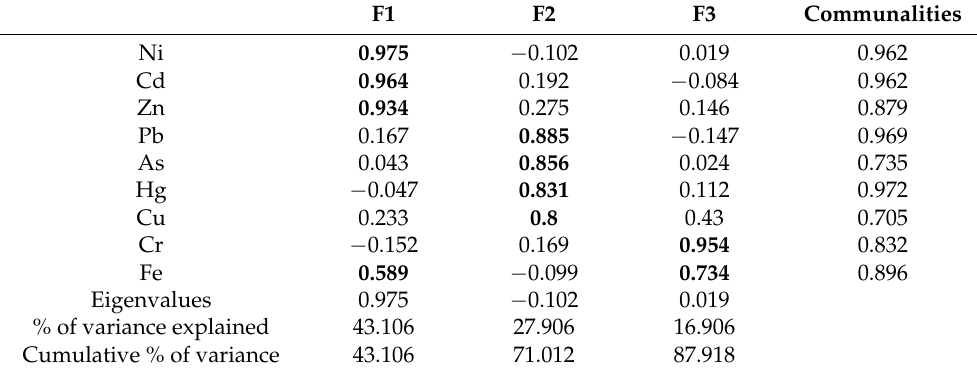
Table 3. Factor loadings in soils.